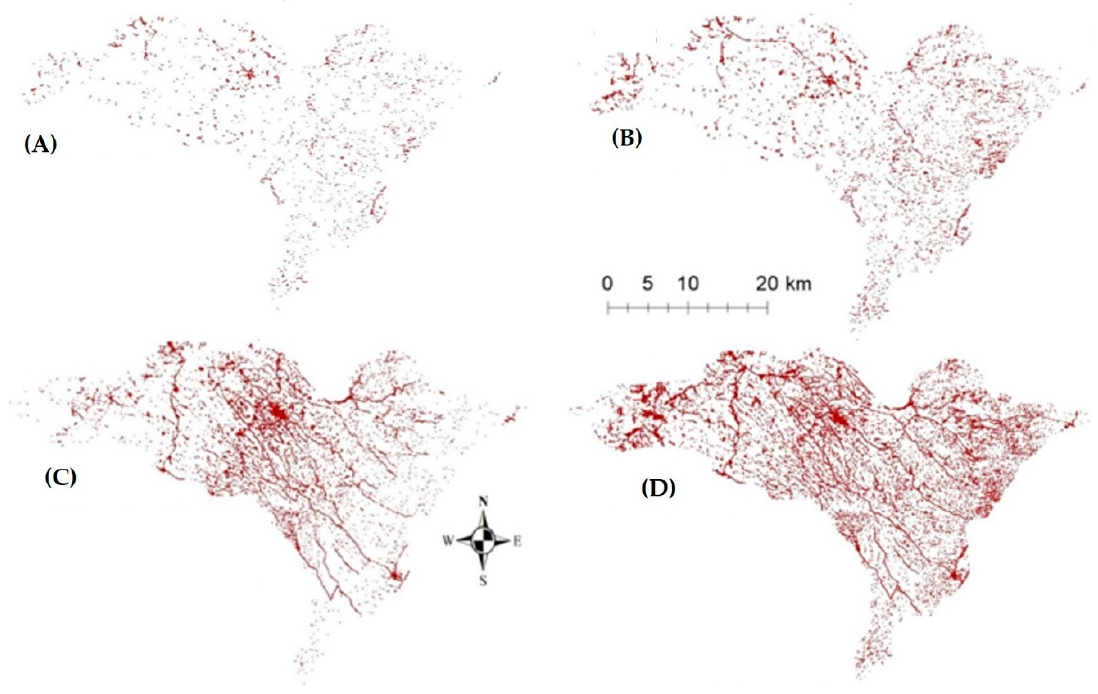
Figure 3. Urbanization development in the watershed in ( A ) 1988—891.23 ha, ( B ) 1998—1427.23 ha,